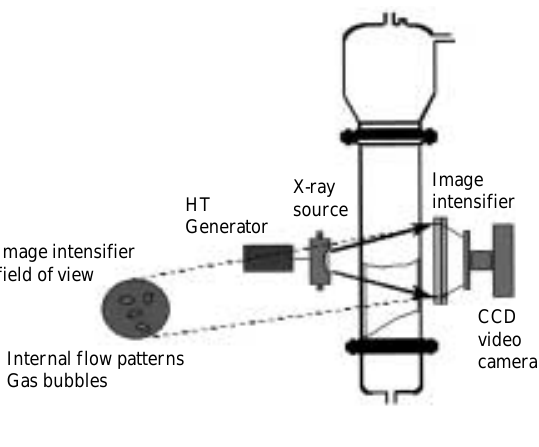
Fig. 2 X-ray imaging